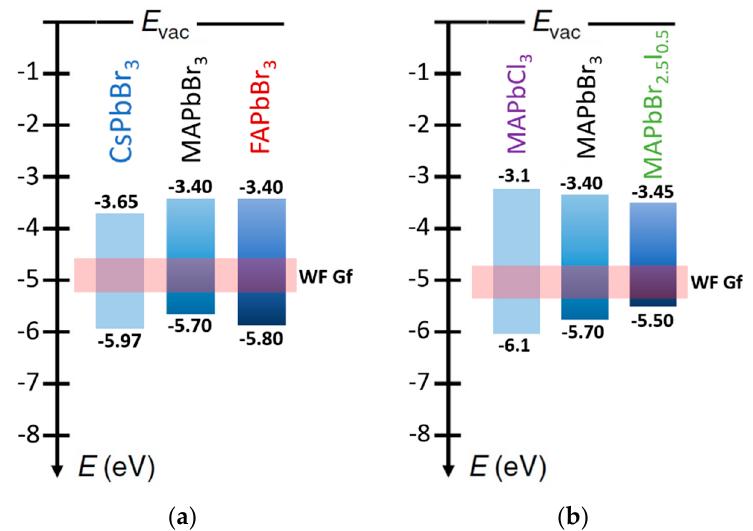
Figure 7. Band structure diagrams of different cation ( a ) and anion ( b ) halide perovskite compositions, and their comparison with the graphene flakes (GF) work function (WF). Chem. Commun., 2020, 56 , 8956–8959 . Reproduced by permission of The Royal Society of Chemistry (RSC) .